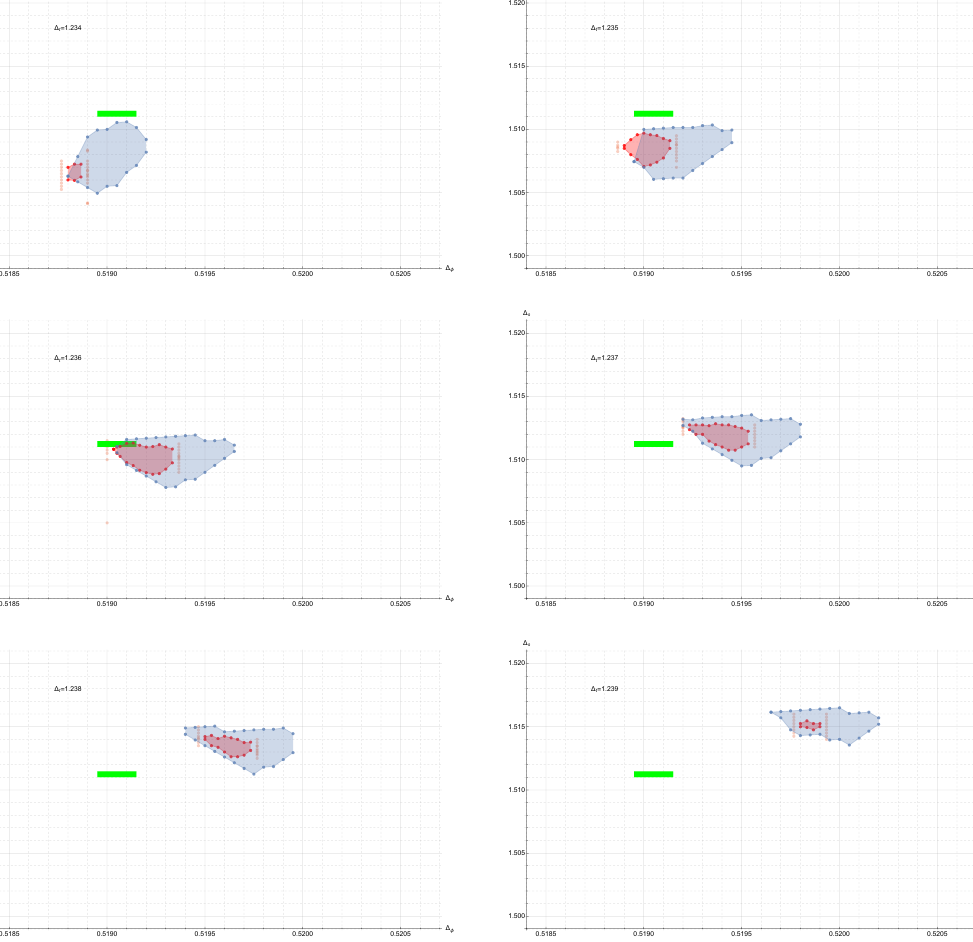
Figure 1 . The island from the mixed correlator bootstrap of the O(2) model. Here, the red regions are our results at (cid:3) = 25; the blue regions are those obtained in appendix B of [35]; and the green rectangle shows the Monte-Carlo results of